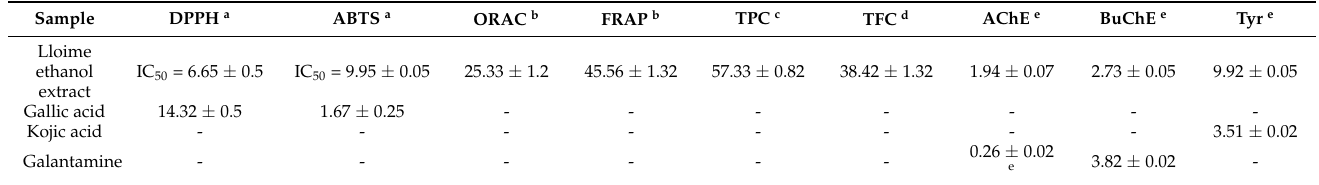
Table 2. Scavenging of the 1,1-diphenyl-2-picrylhydrazyl Radical (DPPH), radical ABTS, (ABTS),